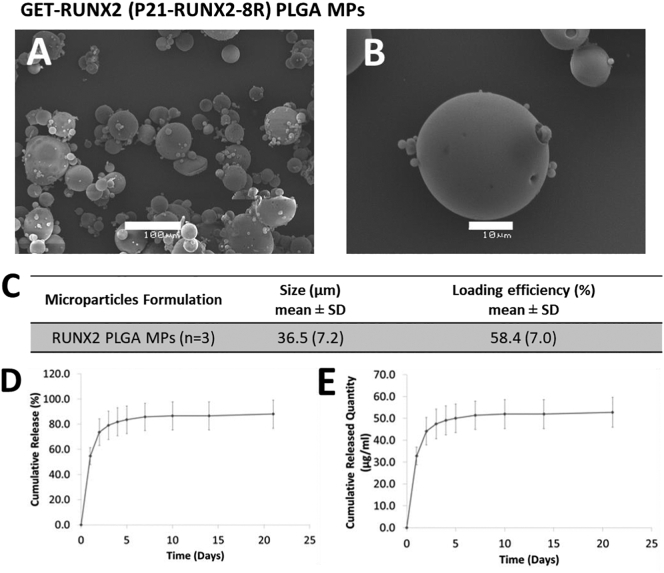
MP characterization and P21-RUNX2-8R-FITC in vitro release profile (pH 7.4 at 37 °C). MPs were fabricated using PLGA (50:50), loaded with P21-RUNX2-8RFITC (0.5% (w/w)), mixed with PBS 0.1% (w/w) and L-Histidine 25% (w/w). (A, B) SEM analyses for MPs (scale bars represent (A) 100μm and (B) 10 μm). (C) Summary of size characterization and corresponding loading efficiencies (n = 3). (D, E) Protein release quantified using Micro BCA assay kit. (D) Relative cumulative protein release. (E) Cumulative protein quantity (using same data as D). Error bars indicate SD (n = 3).